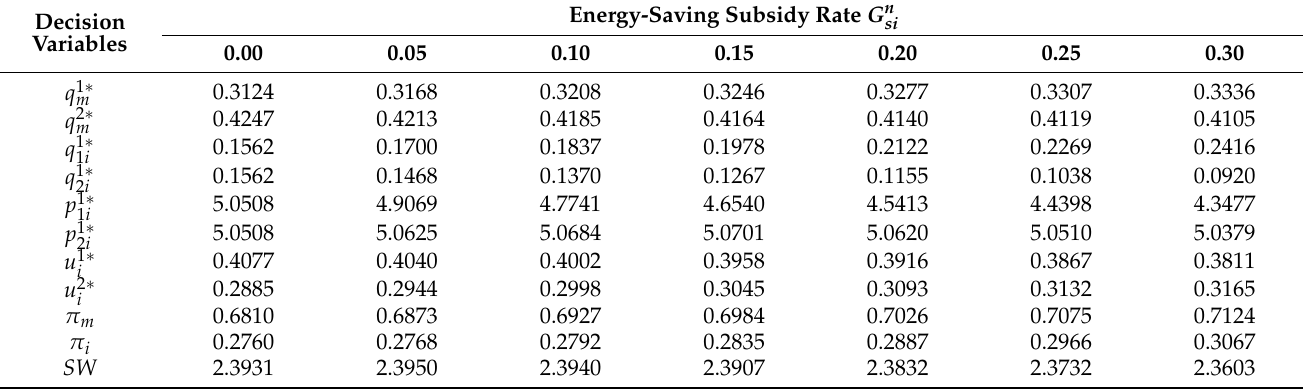
Table A1. The equilibrium result of government subsidies to all retailers in market 1 when demand scale for HEEP and LEEP is equal.